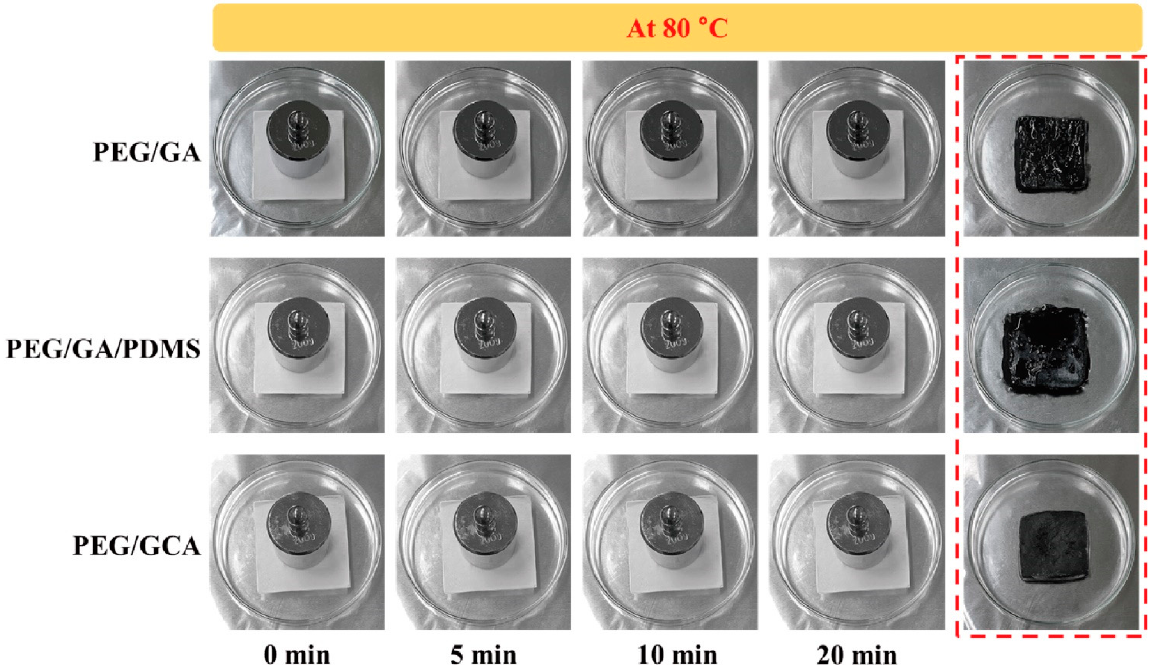
Figure 7. Form-stable photographic images of the PEG composites under the external force at 80 °C. The PEG/GA and PEG/GA/PDMS show the damage of structures after removing the weight. The PEG/GCA keeps initial state without any leakage due to the high mechanical property of GCA.